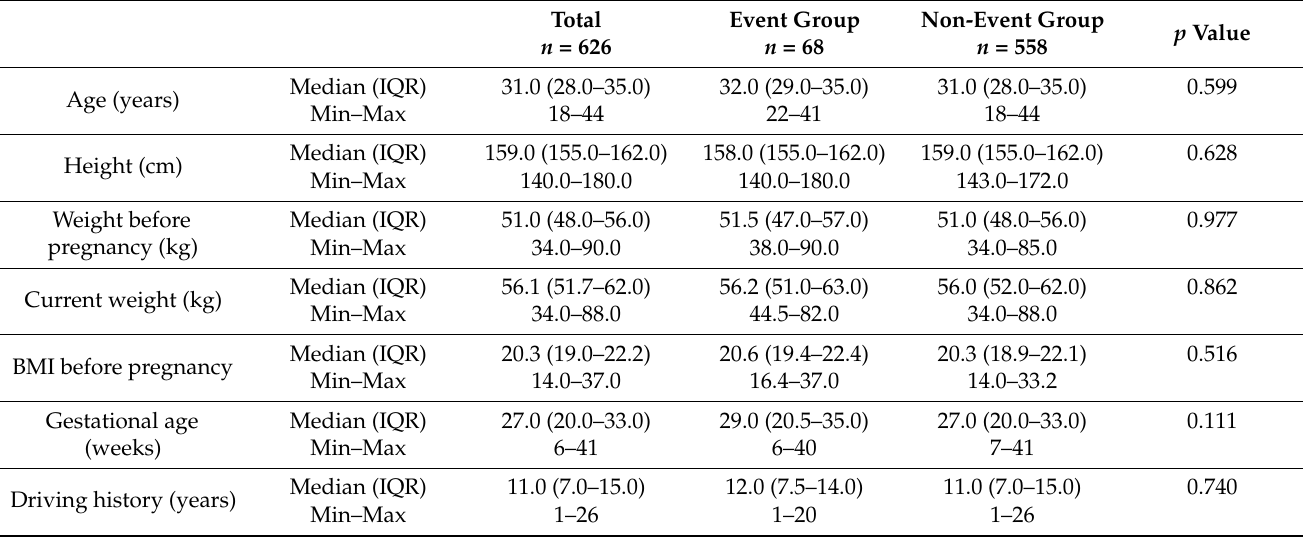
Table 1. Comparison of the basic characteristics between event and non-event groups.